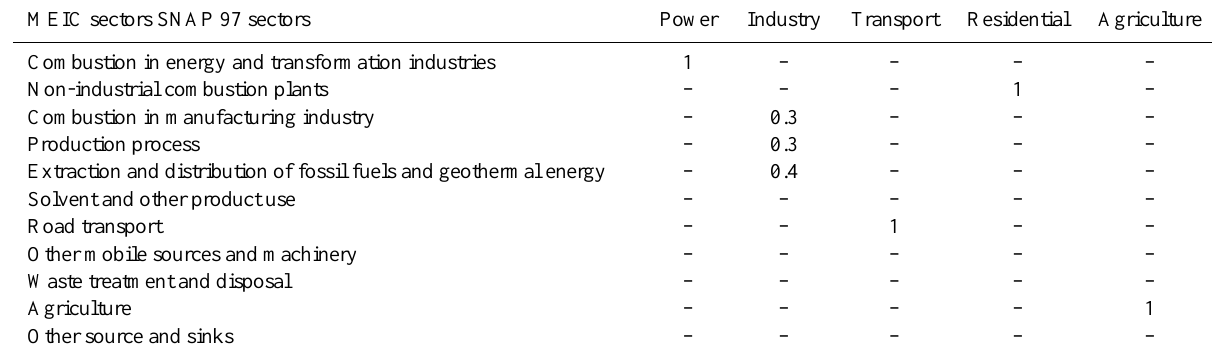
Table 2. Estimated redistribution of MEIC sectors over SNAP 97